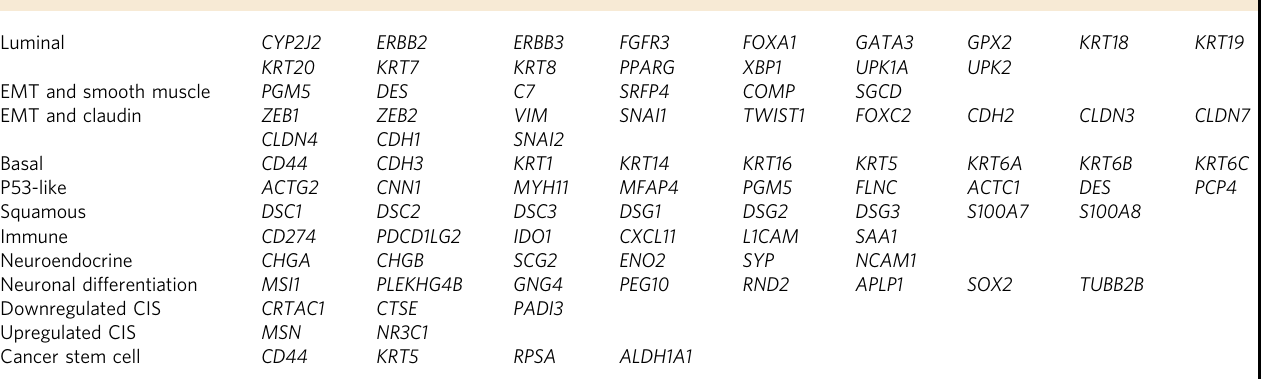
Table 1 Examples of lineage genes used for analysis.